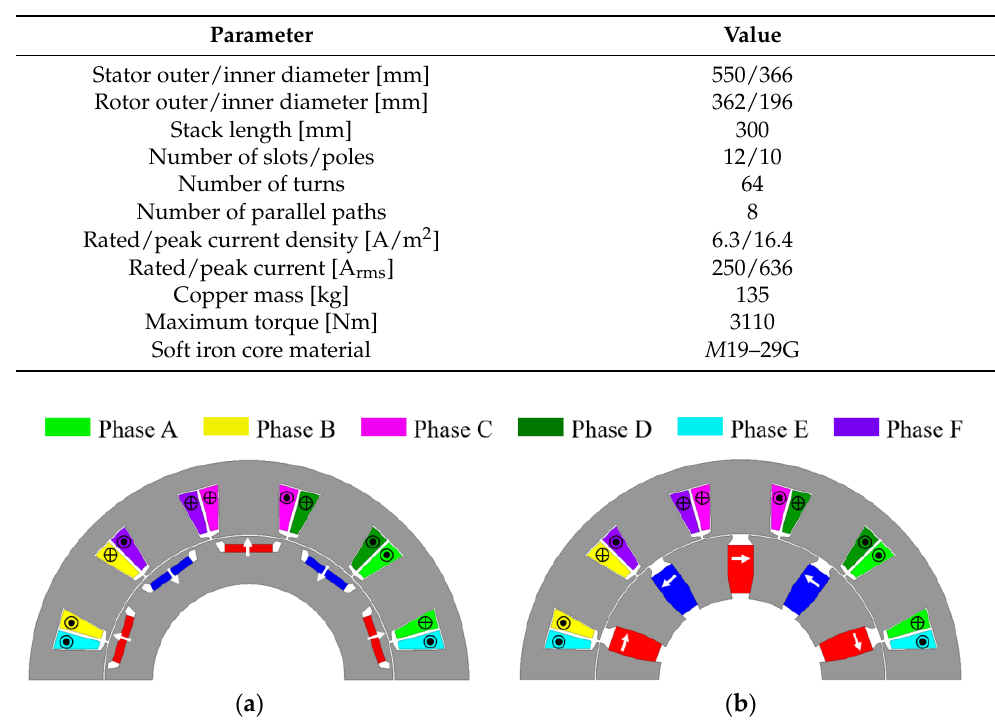
Table 1. Specifications of benchmark motor. Data from [3].